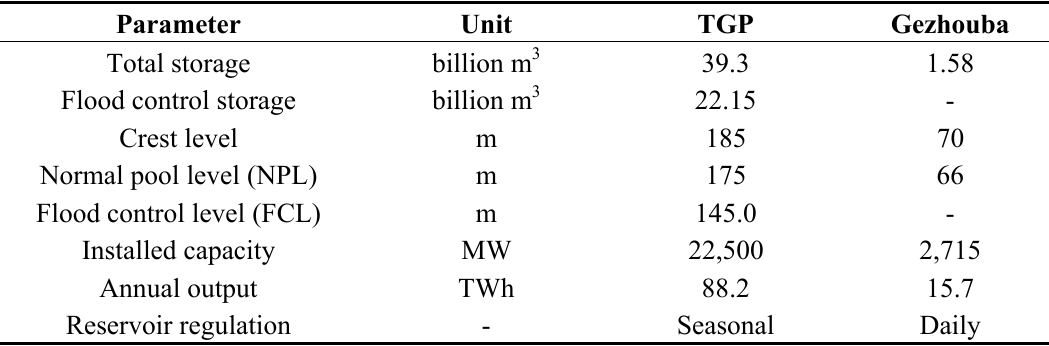
Table 1. List of the characteristic parameters of the Three Gorges Cascade